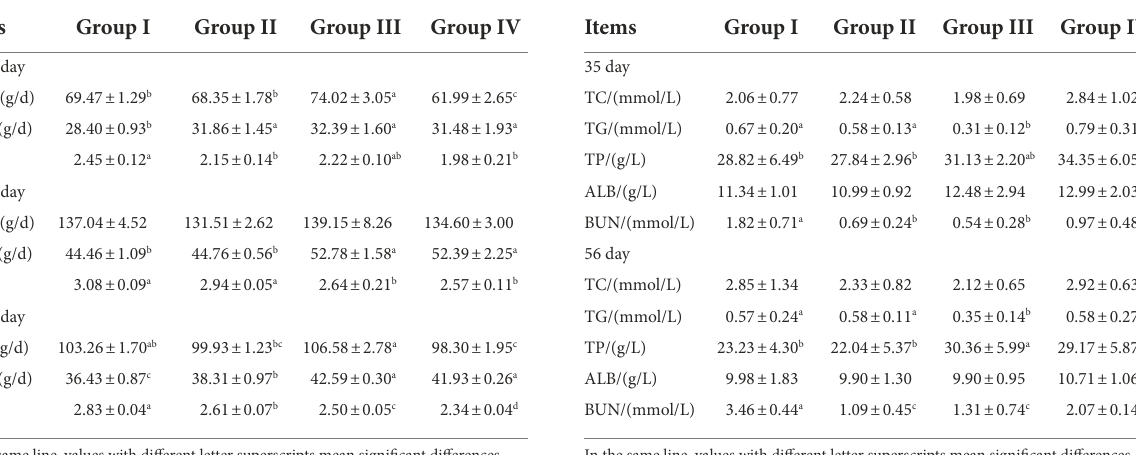
TABLE 4 Effects of different levels of FGSM on growth